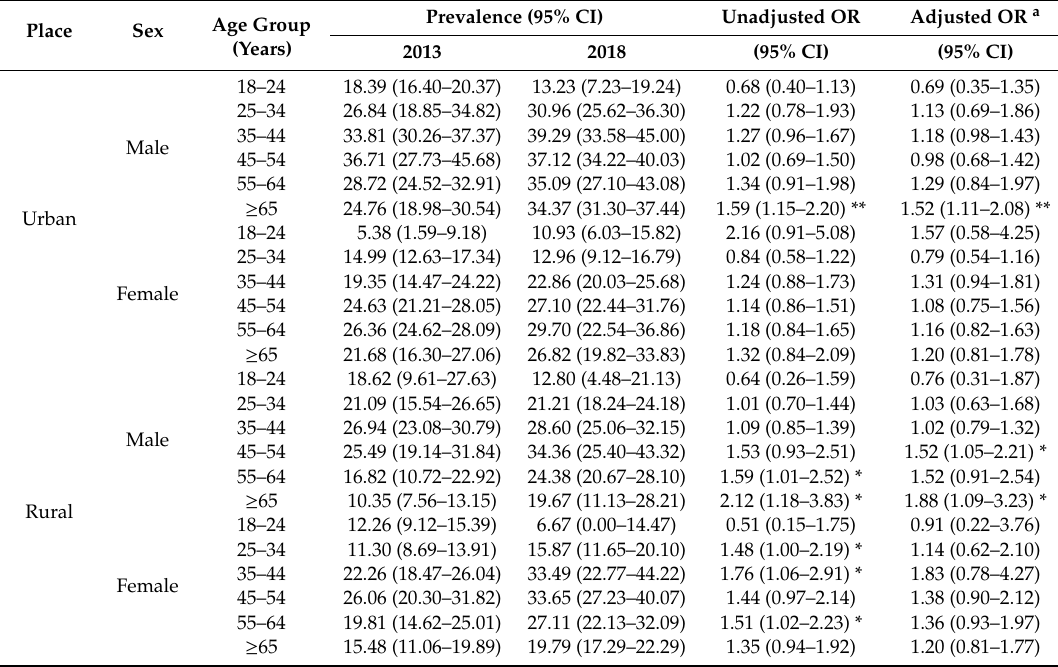
Table 2. Place-, sex- and age-specific overweight prevalence rates among inhabitants between 2013 and 2018 in Hunan Province,